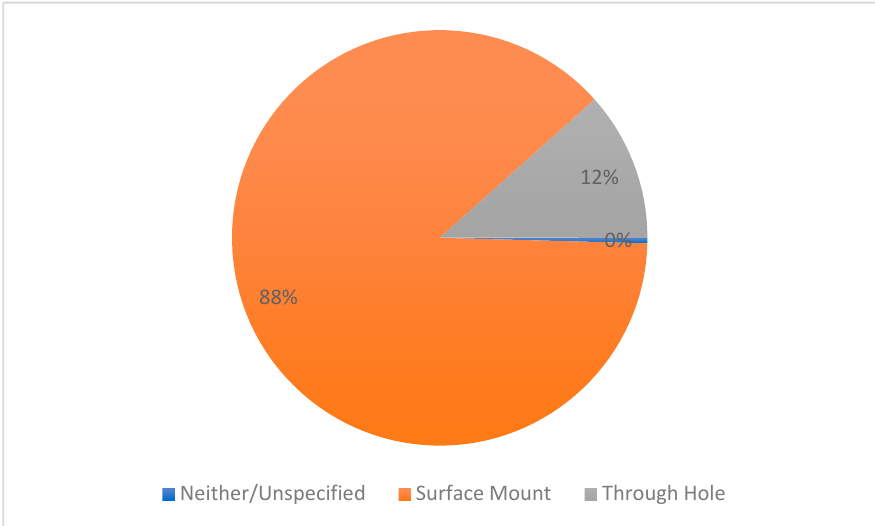
Figure 5. Number of surface mount versus through-hole components in stock product offerings.